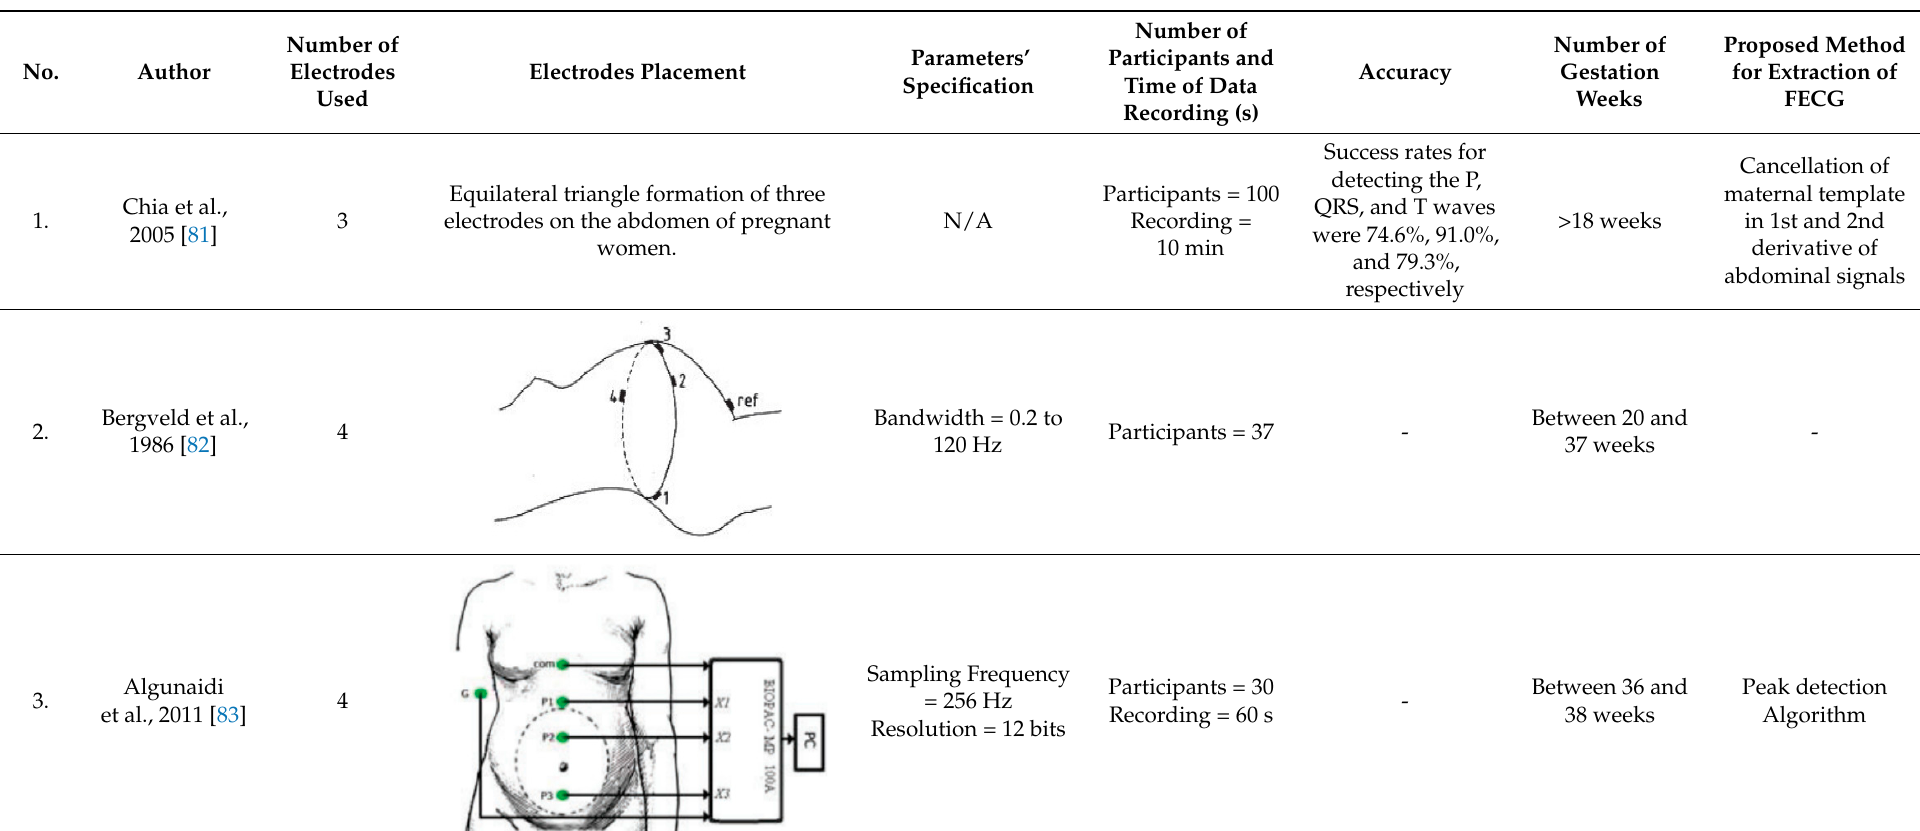
Table 1. Comparison of different electrode placement for FECG monitoring.